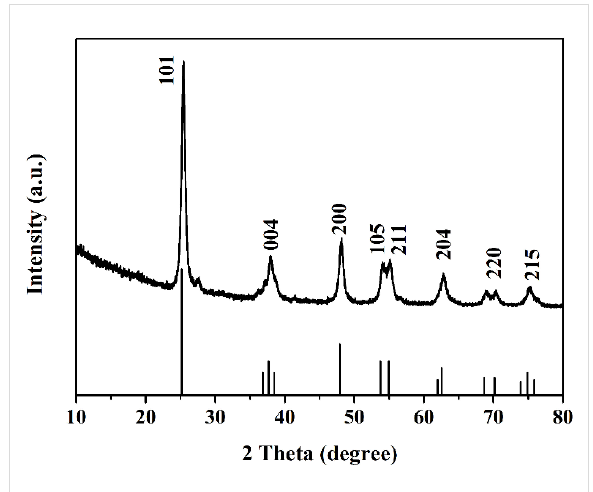
Figure 3: Representative XRD pattern of porous TiO 2